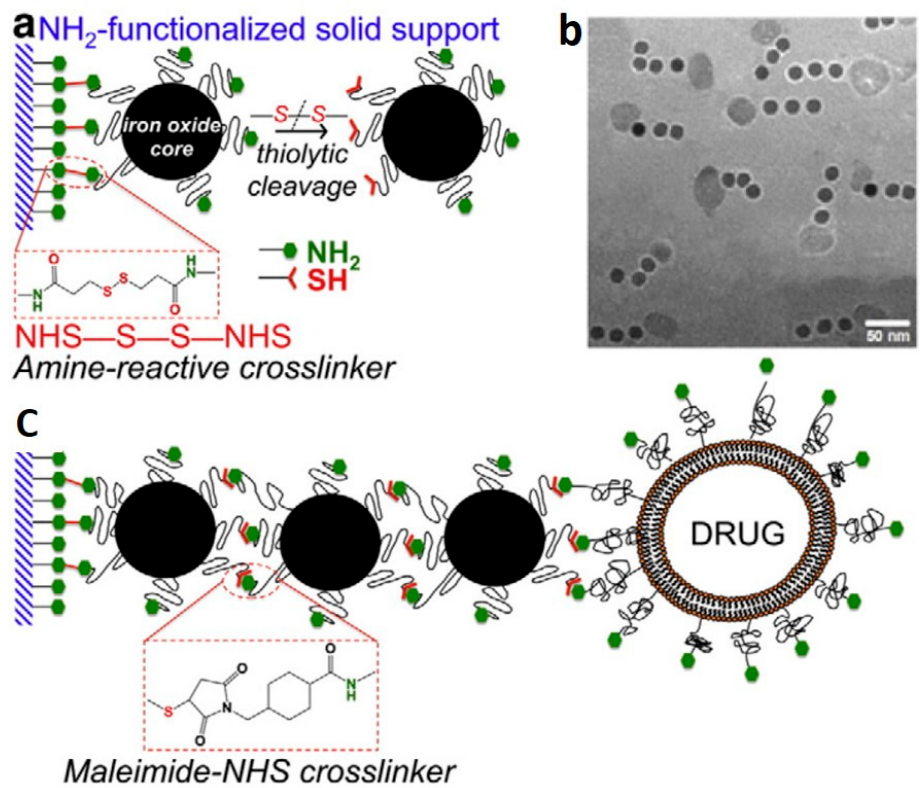
Figure 10. Reaction scheme of the controlled assembly of magnetic nanochains using solid-phase chemistry. ( a ) Precise control over the chemical functionality of amines and thiols on the surface of individual magnetic nanoparticles. ( b ) TEM image of fabricated nanochains, each one composed of three units of nanoparticles. ( c ) Schematic illustration of a multi-step process to produce nanochains with a terminally bonded liposome drug carrier. Reproduced from [110], Copyright 2013, with permission from Elsevier.